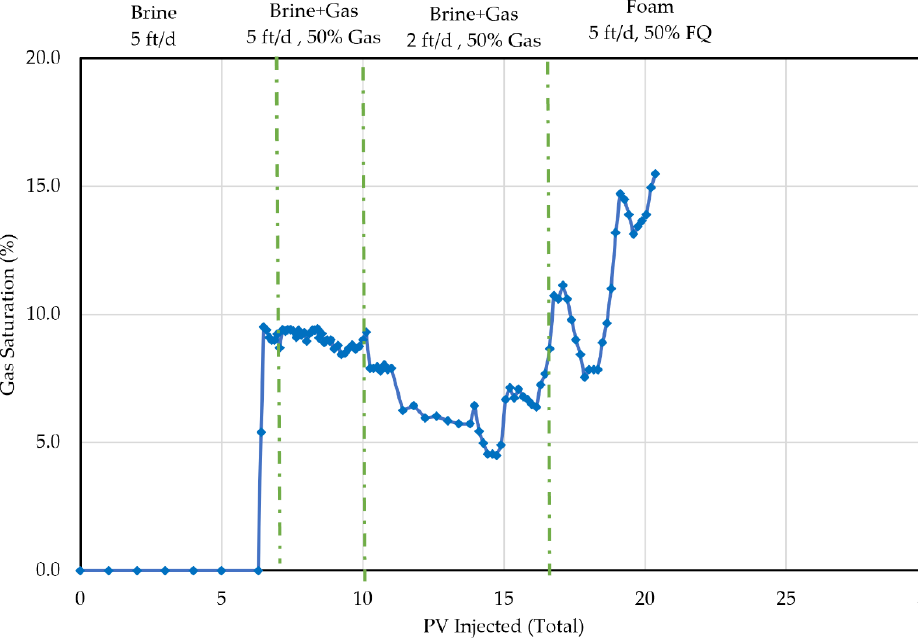
Figure 10. Combined gas saturation in both cores for DI-Exp 1.